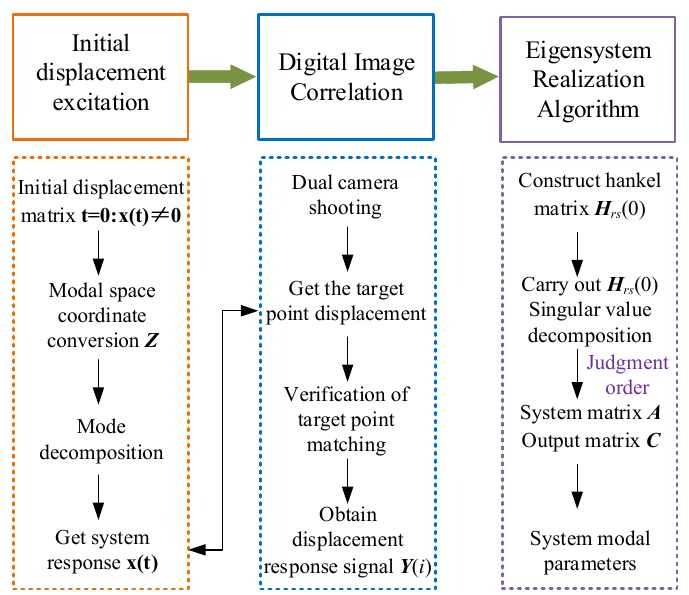
Figure 3. Flow chart of modal identification of ultralow-frequency flexible structure.